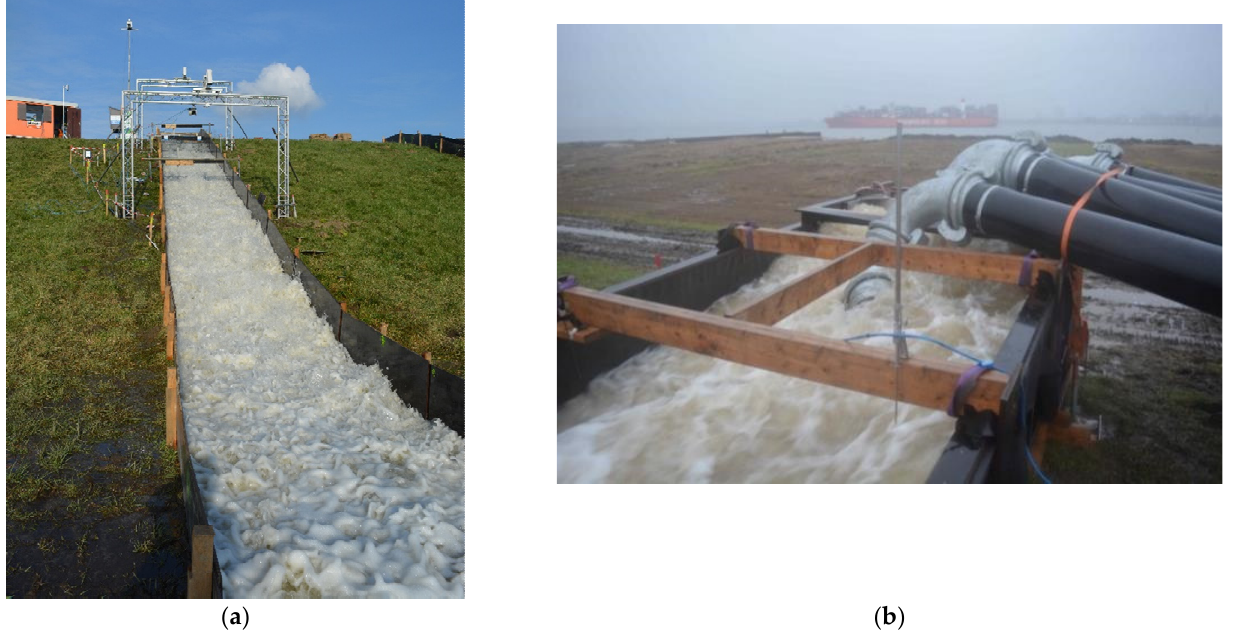
Figure 3. ( a ) Overflow in progress; ( b ) Overflow generator at maximum discharge of 1100 L/s.